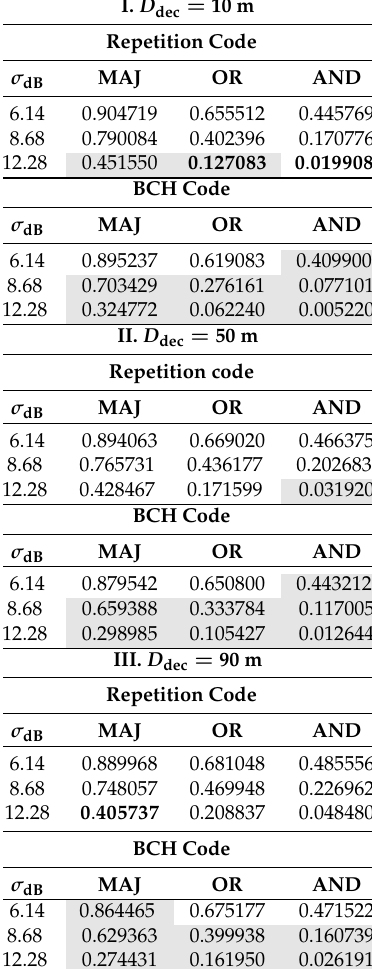
Figure 6. Performances of BCH and Repetition codes over the full-interleaved flat Rayleigh fading channel, with maximum-likelihood soft-decision detection without channel state information. Table 2. AUCs for the coded MAJ, OR, and AND decision rules, with r B = { 5/15,6/31,7/63 } and r R = { 1/3,1/5,1/9 } , for σ dB = 6.14,8.68, and 12.28 dB, L = 50 m, and D dec = 10,50, and 90 m. The gray-shaded areas and bold-faced values are explained in the text. I. D dec = 10